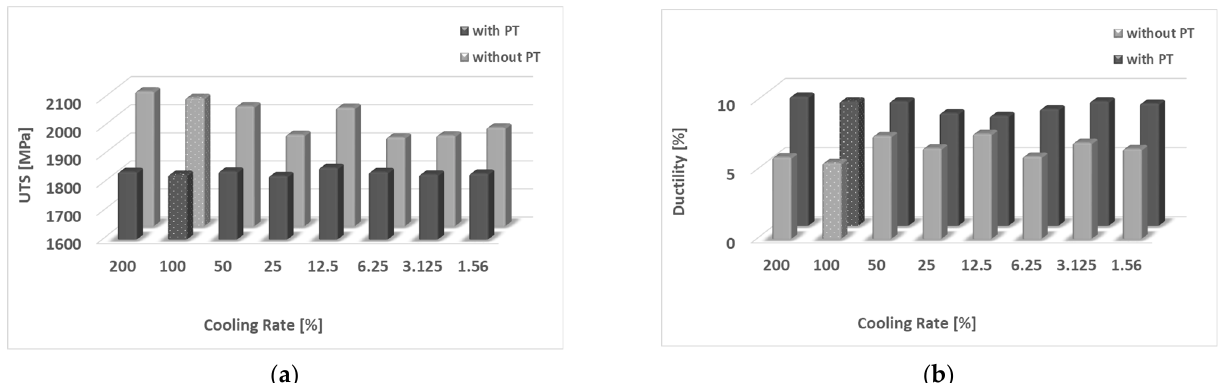
Figure 3. ( a ) Ultimate Tensile Strength and ( b ) Ductility versus selected cooling